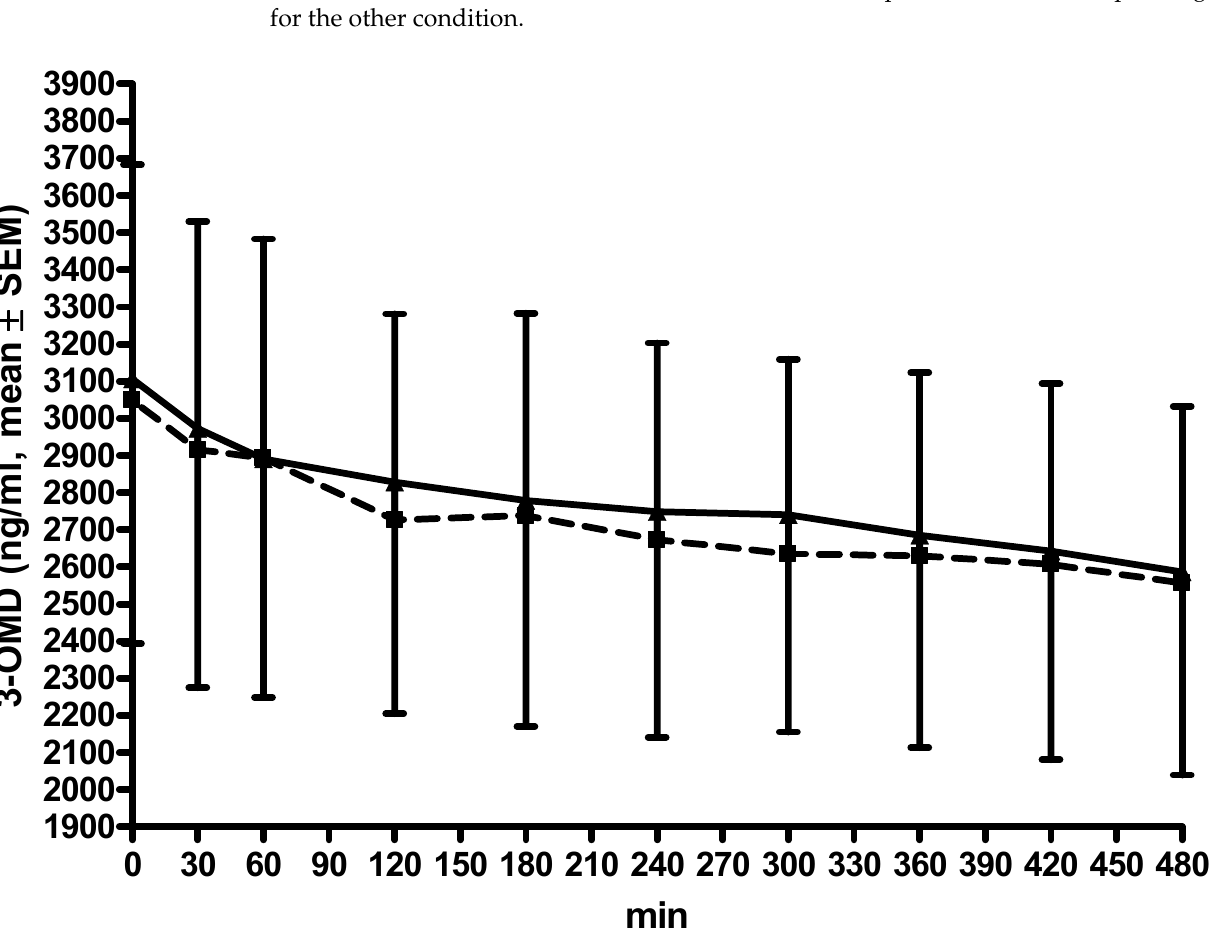
Figure 2. Curve of 3-OMD levels. All data are given as mean ± standard error of means (SEM); min, minutes; opicapone was taken at − 30 min; L-dopa and 3-OMD plasma levels are given in ng/mL, thcys concentrations in µmol/L; lines of the L-dopa/carbidopa plus opicapone condition are dashed with (cid:4) ; lines of the L-dopa/carbidopa/entacapone condition are continuous with (cid:78) ; error bars are above the curve of the L-dopa/carbidopa plus opicapone condition; error bars are below the curve of the L-dopa/carbidopa/entacapone condition.